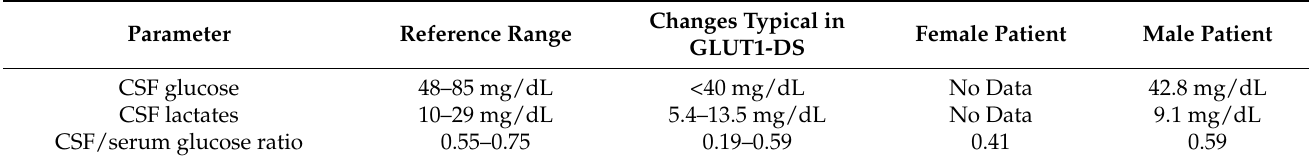
Table 1. Cerebrospinal fluid (CSF) examination in both patients.